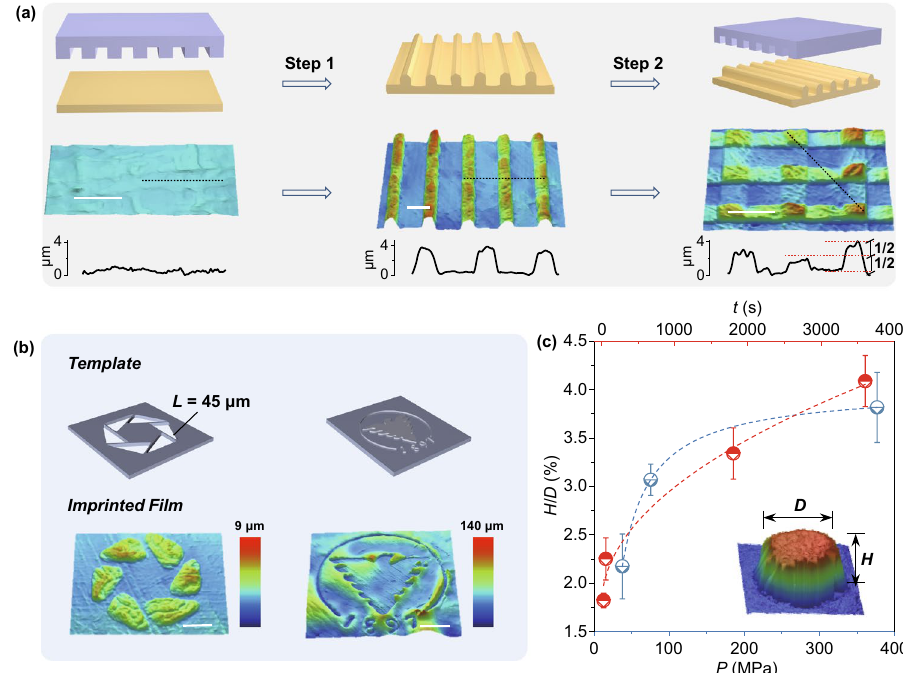
Fig. 5 a Representation of multi-imprinting process from flat to micro-pattern stages. Scale bar, 50 μm. b Surface patterns on Pi-GOSs through micro imprinting: simple hexagon formed by triangles (left), embossment of the ZJU logo (right). Scale bars, 50 μm (left), 2 mm (right). c The curve of height-diameter ratio versus pressure and time. Dashed lines correspond to the fitting results and points represent experiment results (error bars are based on the standard error of the